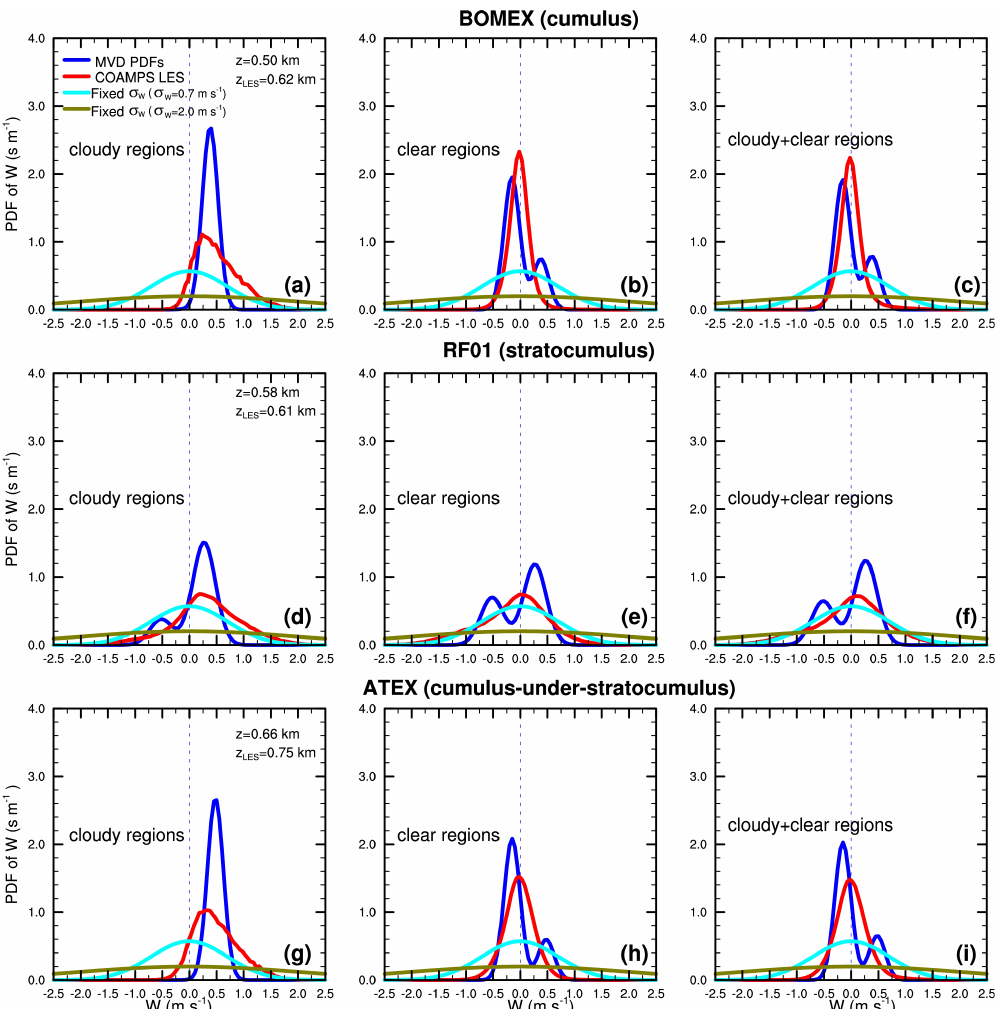
Fig. 4. Probability density function (PDF) of vertical velocity ( w ) in cloudy regions, clear regions, and whole sky (cloudy+clear regions) averaged over the same periods as in Fig. 3, for BOMEX in (a) , (b) , and (c) , RF01 in (d) , (e) , and (f) , and ATEX in (g) , (h) , and (i) . z and z LES refer to the cloud base heights from the MVD PDFs and from COAMPS LES,